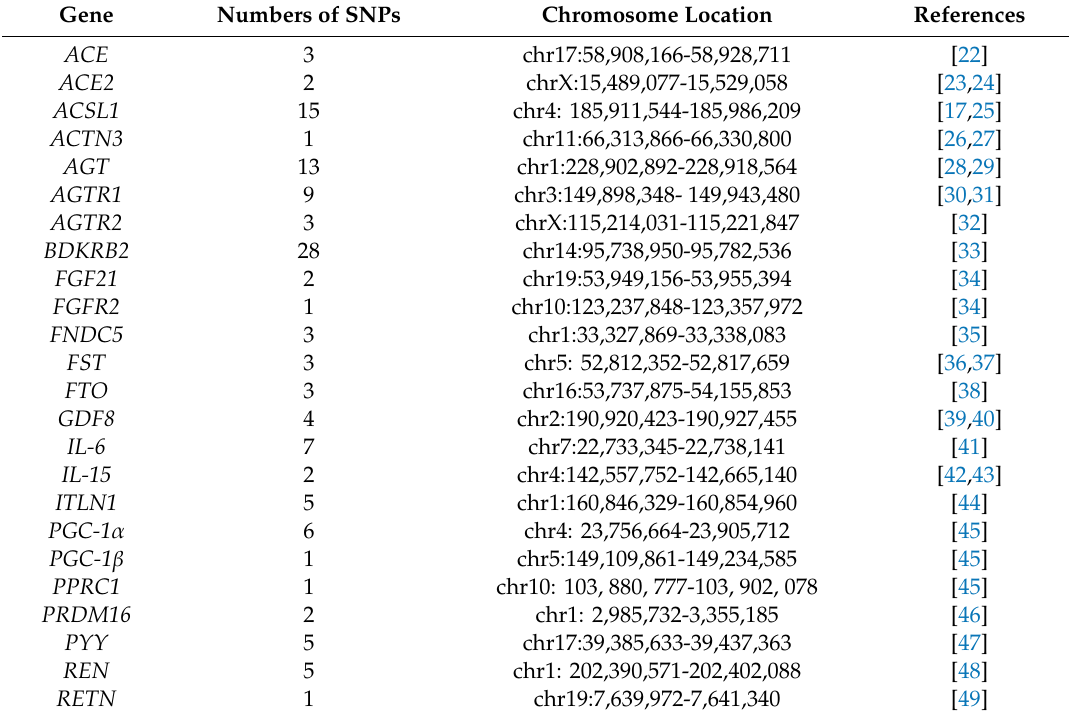
Table 1. Target genes selected for the